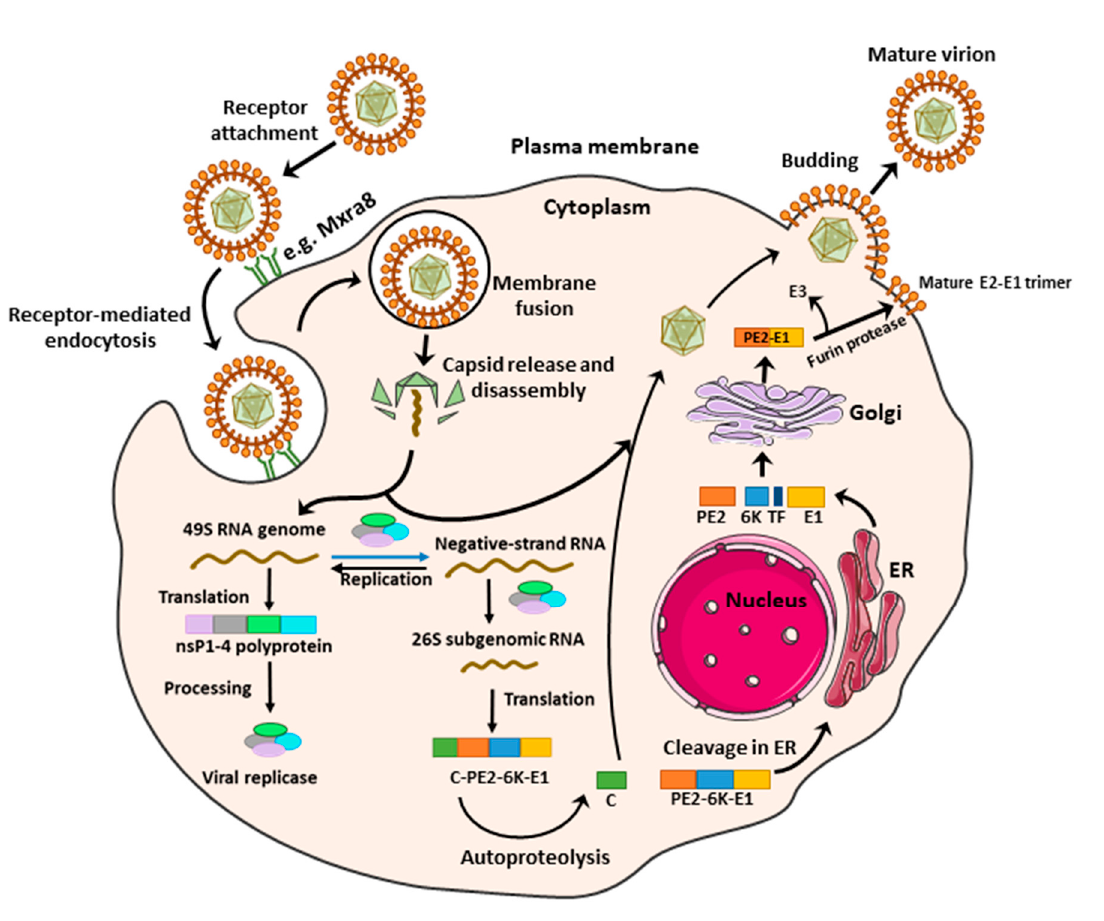
Figure 1. Replication cycle of arthritogenic alphaviruses. Alphaviruses enter the host cell by endocytosis following the binding of the envelope glycoprotein E2 to specific receptor(s) on the cell surface. Within the endosome, the low pH triggers the fusion of the viral envelope glycoprotein E1 with the endosomal membrane, leading to the release of the nucleocapsid into the cytoplasm. The nucleocapsid disassembles to liberate the viral genome, which is translated to produce the viral nonstructural proteins (nsP1–4). After processing, the nonstructural proteins complex to form the viral replicase, which catalyzes the synthesis of a negative-sense RNA strand to serve as a template for synthesis of both the full-length positive-sense genome and the subgenomic (26S) RNA. The subgenomic (26S) RNA is translated to produce the structural polyprotein (C-E3-E2-6K-TF-E1), which is then cleaved and processed in the Golgi apparatus and endoplasmic reticulum (ER) to produce the individual structural proteins, followed by assembly of the viral components. The assembled virus particle is released by budding through the plasma membrane, where it acquires the envelope with embedded viral glycoproteins. C = Capsid protein, E = Envelope glycoprotein, TF = Transframe protein.